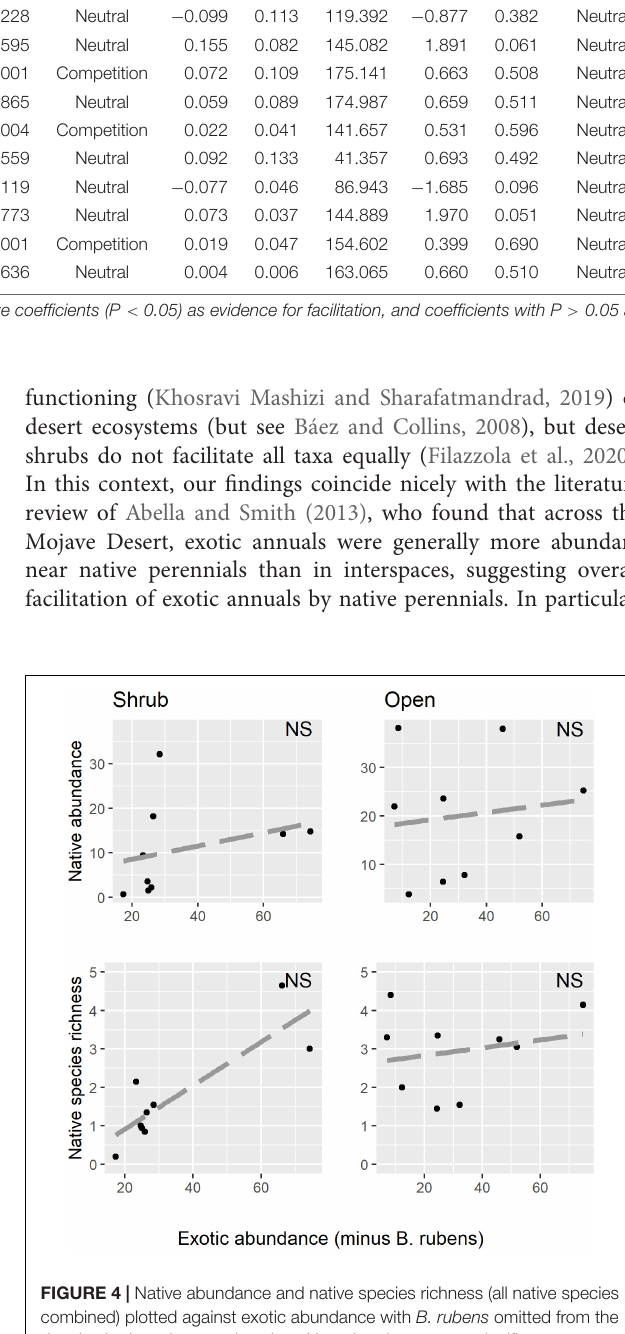
Frontiers in Ecology and Evolution |